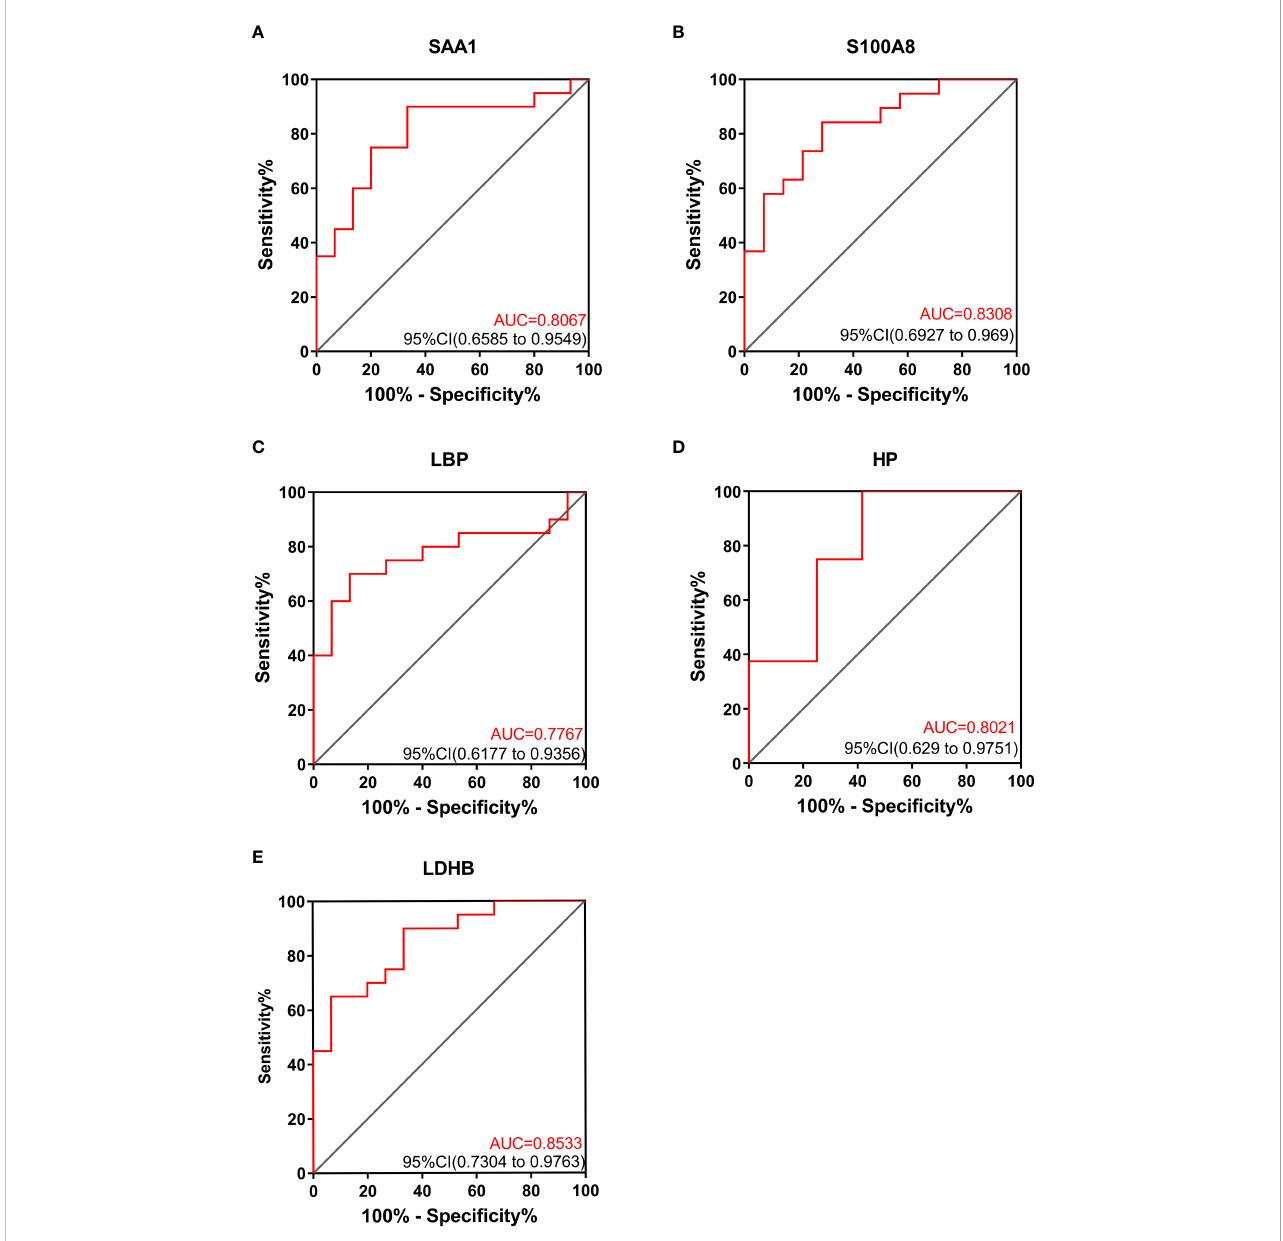
FIGURE 4 ROC curves of SAA1, S100A8, LBP, HP, LDHB between VTE group and non-VTE